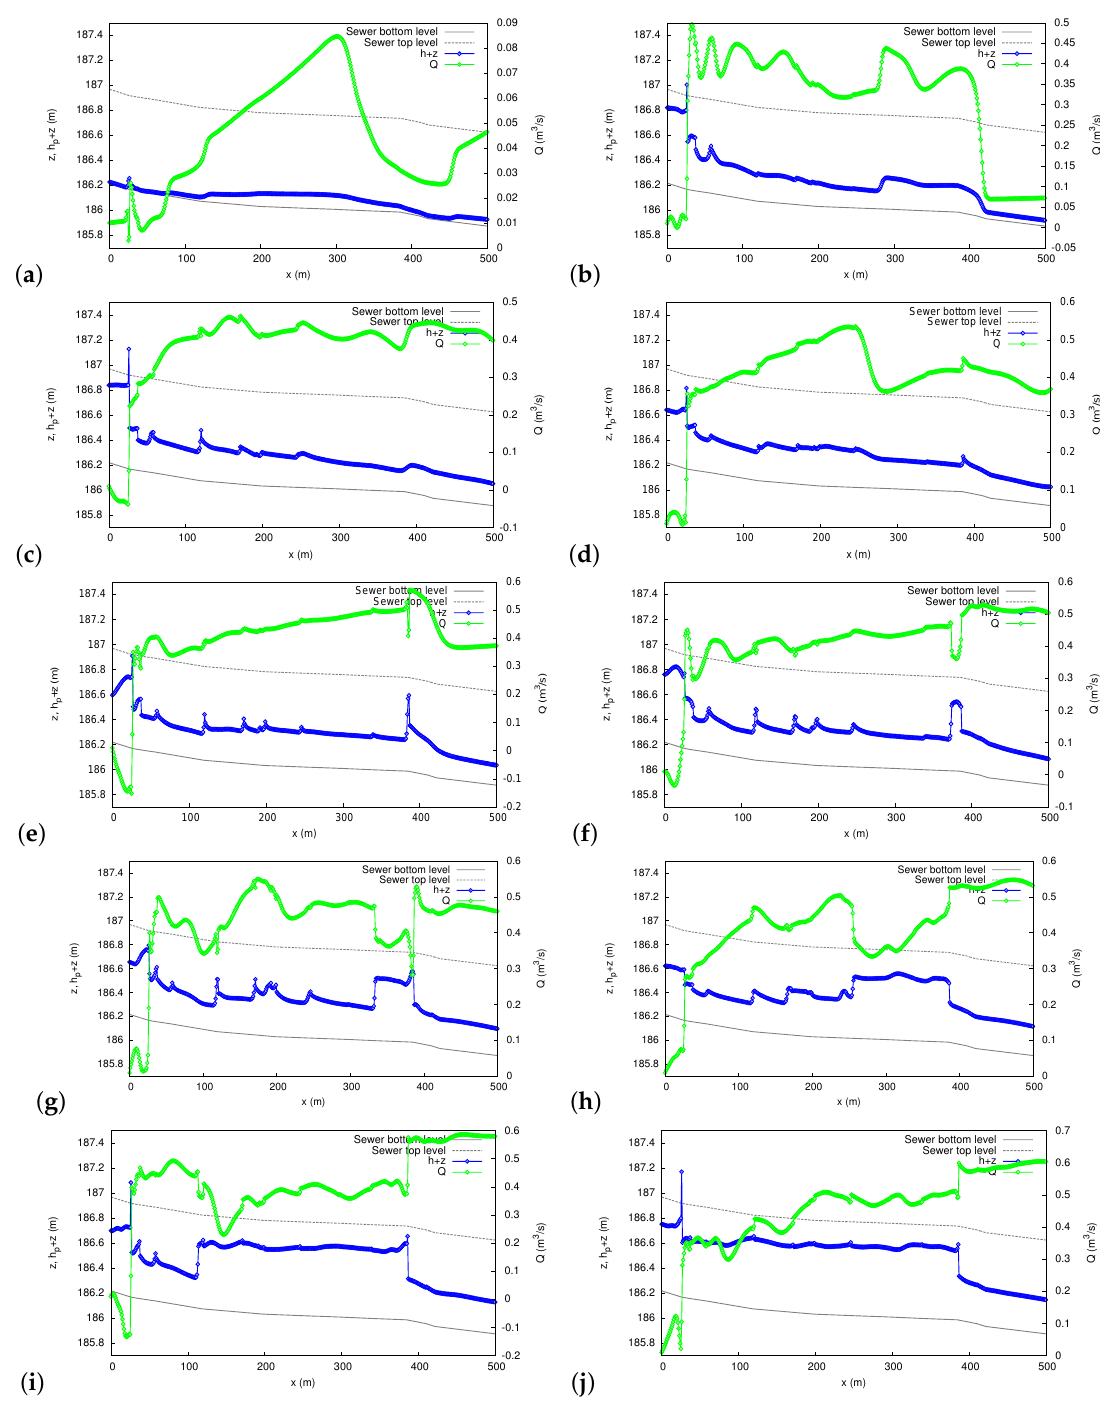
Figure 15. Case 2.2. Network profile at t = 190 s ( a ), 350 s ( b ), 430 s ( c ), 500 s ( d ), 540 s ( e ), 565 s ( f ), 650 s ( g ), 800 s ( h ), 1000 s ( i ), and 2500 s ( j